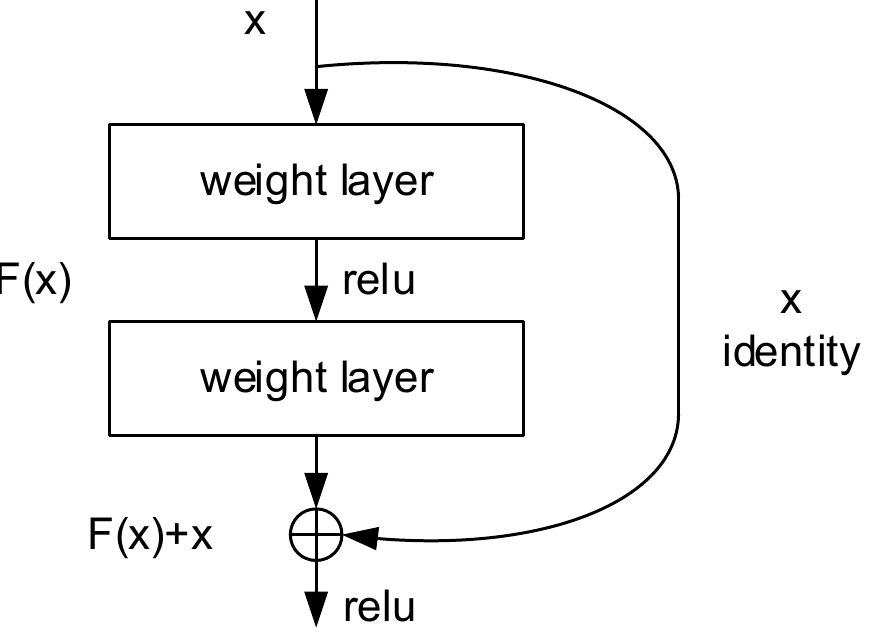
Figure 4. Shortcut Figure 4. Shortcut connection.